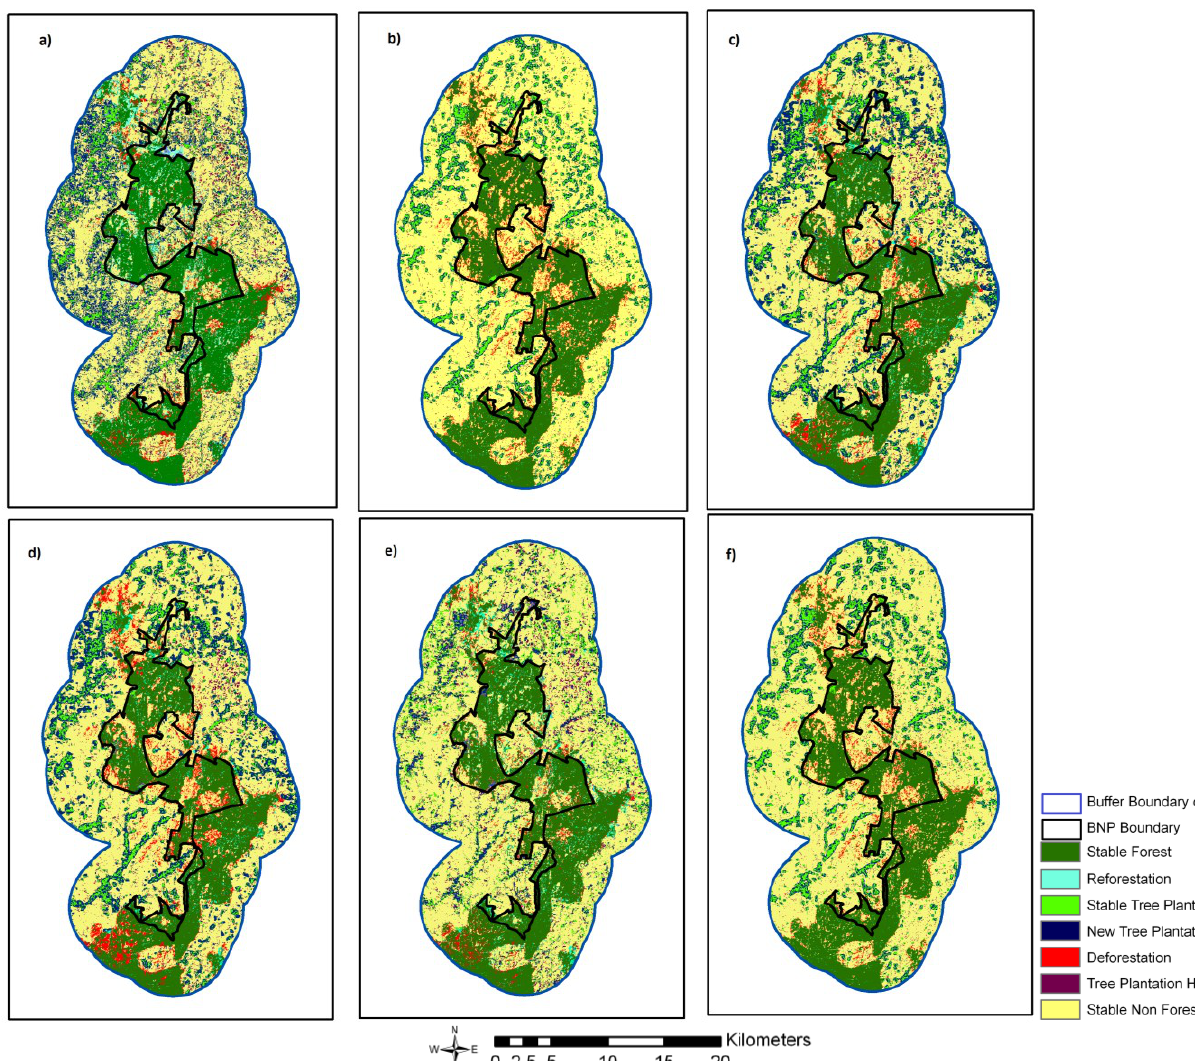
Figure 7. Two-date change trajectory maps giving a comparison of observed vs.